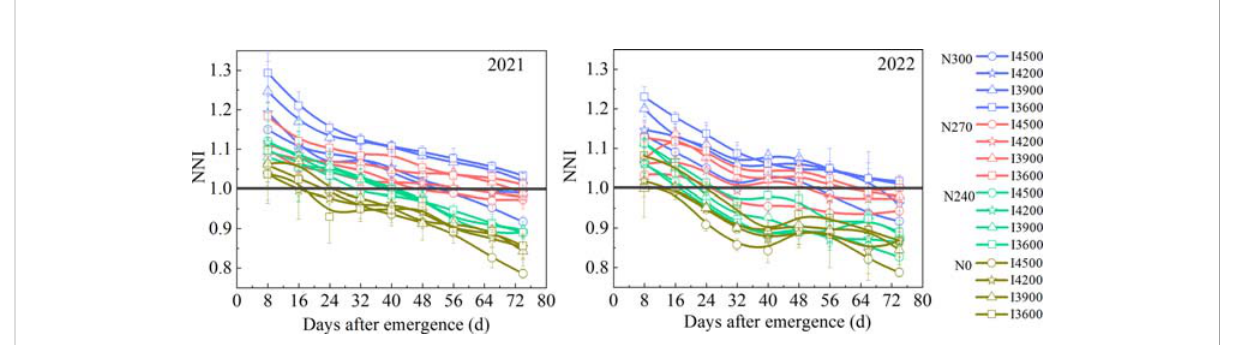
FIGURE 6 Variations in nitrogen nutrition index (NNI) of wheat plants under different treatments. I4500, I4200, I3900, and I3600 indicate 4500, 4200, 3900, and 3600 m 3 ha − 1 irrigation levels, respectively. N300, N270, N240, and N0 indicate 300, 270, 240, and 0 kg ha − 1 nitrogen levels,